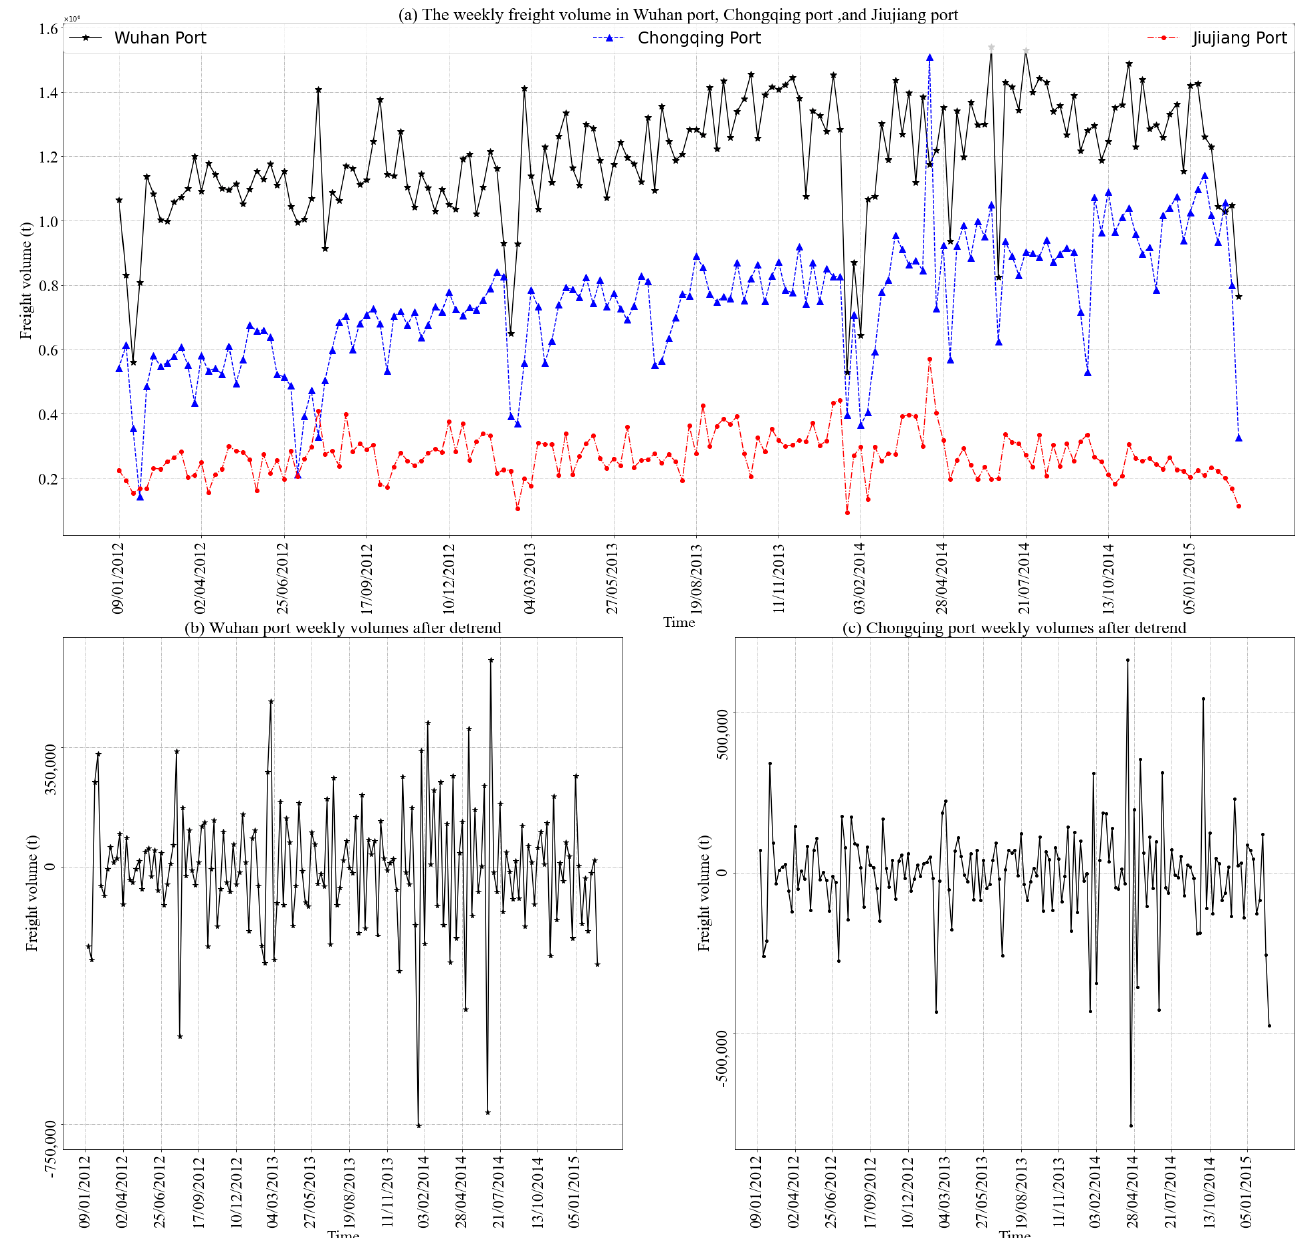
Figure 2. The original and detrending weekly freight volume curves of Wuhan port, Chongqing port, and Jiujiang port.